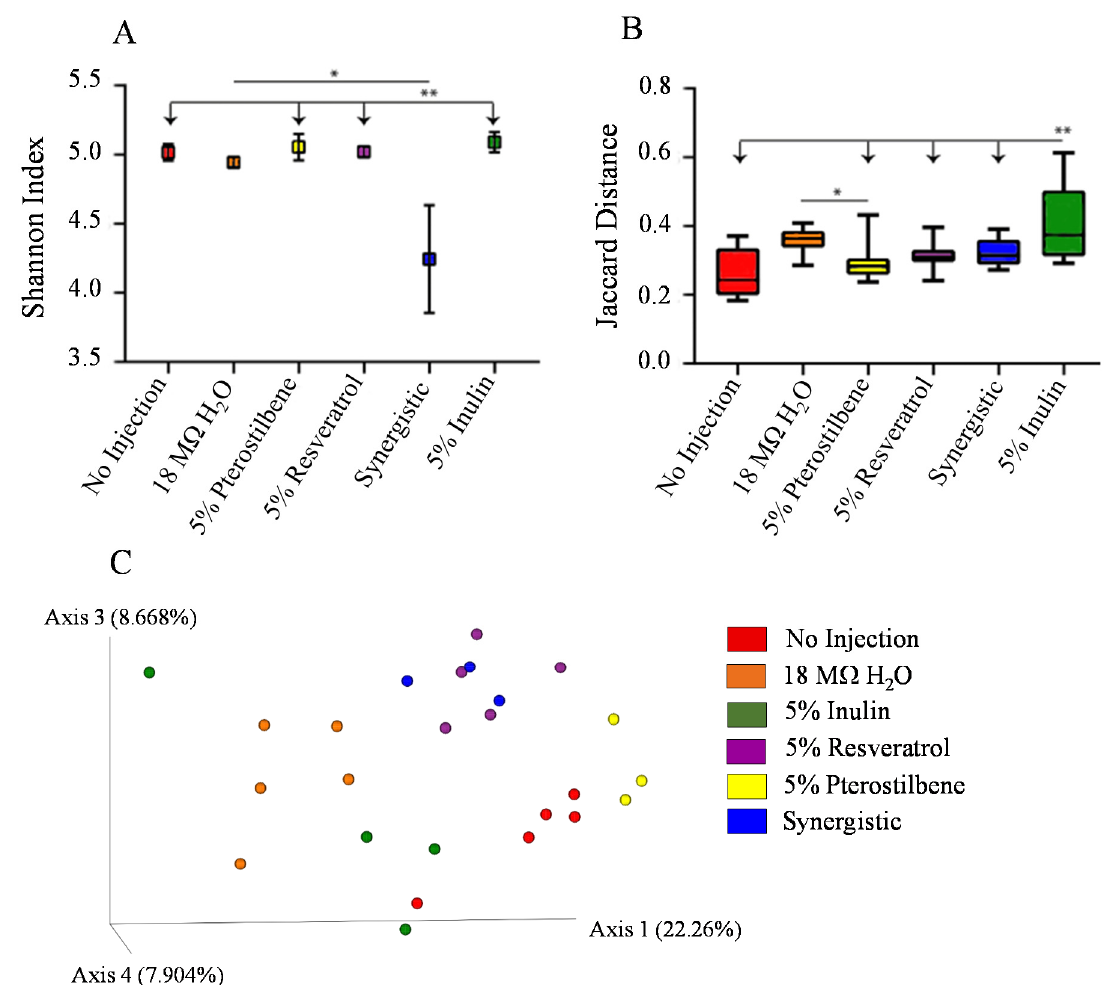
Figure 3. Microbial diversity of the cecal microbiome after the intra-amniotic administration of stilbenes. ( A ) Measure of α diversity using the Shannon Index. ( B ) Boxplot of Jaccard similarity distances within groups, with significant differences between groups (arrows) compared with the 5% inulin group. ( C ) Principal Coordinates Analysis (PCoA) based on the Jaccard similarity distances of cecal microbial communities from the different treatment groups. Each dot represents one animal, and the colors represent the different treatment groups ( n = 5). * p < 0.05. ** p < 0.01.